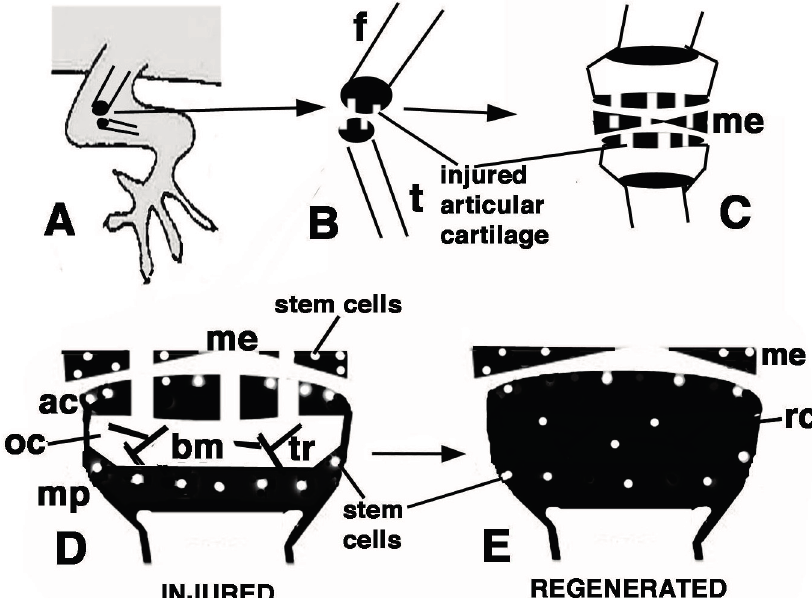
Figure 9. Schematic drawing resuming the present observations. ( A ) depicts a lizard knee where the injury of the articular surfaces is indicated in ( B ); ( C ) depicts the damaged area (white) produced on the articular cartilages and meniscus of the knee; ( D ) further depicts the structure of an injured epiphyses and meniscus with the position of Long Retaining Cells (LRC)/telomerase positive and putative stem cells in the articular cartilage and metaphyseal plate indicated; ( E ) depicts that the regenerated cartilage (in black) occupies the entire epiphyses at 21 − 32 days (four-and-a-half weeks) post-injury while stem cells appear sparse and not localized in the surface or metaphyseal plate, and are also present in the meniscus. (ac, articular cartilage; bm, bone marrow; f, femur; me, meniscus; mp, metaphyseal (growth) plate; oc, ossification center; rc, regenerated cartilage; t, tibia; tr, bone